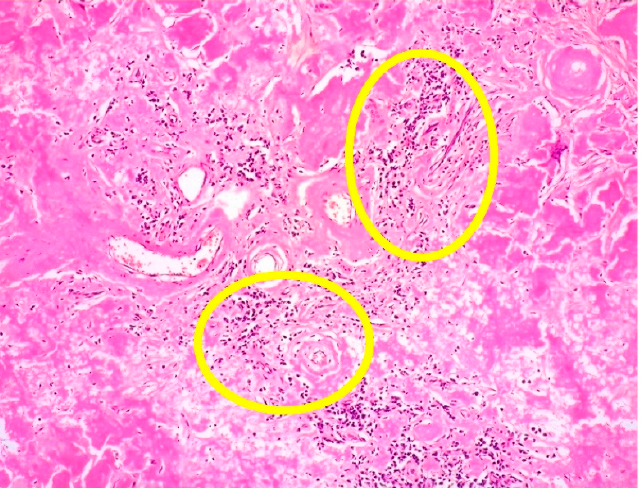
Figure 5. Cutaneous amyloidoma : amorphous and eosinophilic material, admixed with sparse plasma cells within dermis and subcutis (some foci of plasma cell infiltrate within yellow circles) (HE, 40× magnification; original image from Prof. S.A.).